Question: State the chart type depicted above.
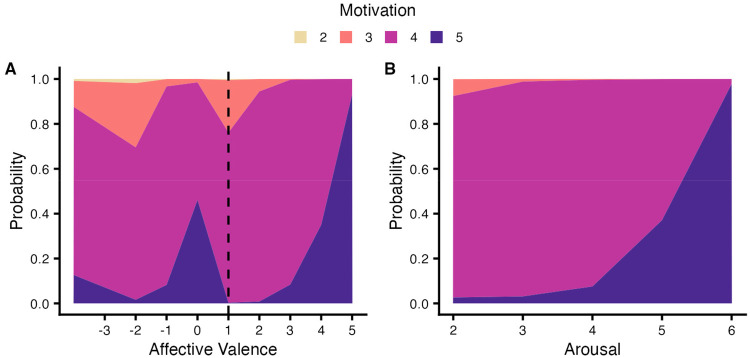
Answer: line